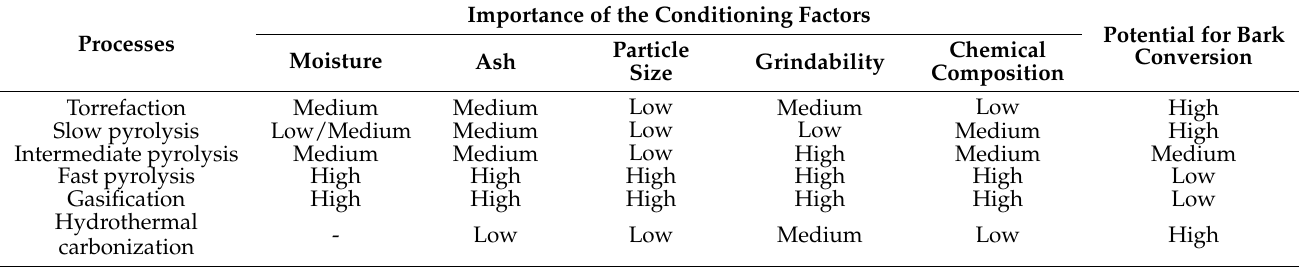
Potential for Bark